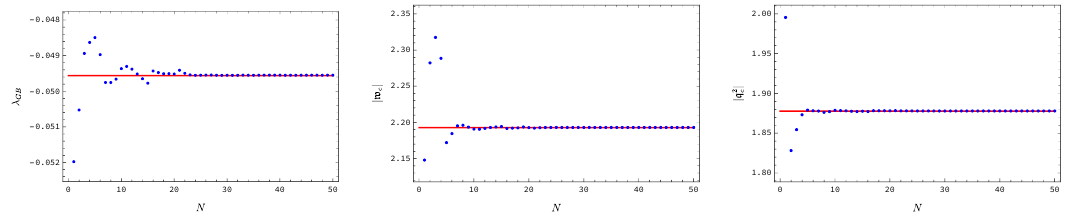
Figure 21 . Parameters of the critical point λ ( N ) , | w c ( N ) | , q 2 ( N ) obtained from the perturbative c GB analysis of eqs. (2.3) supplemented by a Padé resummation (blue dots). The orders of the Padé approximant [ a/b ] were chosen as follows: [ N/N ] for 1 ≤ N < 5 ; [ N − 3 / 2] for 5 ≤ N < 15 ; [ N − 11 / 10] for 15 ≤ N ≤ 50 . The red lines are the non-perturbative results given by eqs. (5.16), (5.17) and